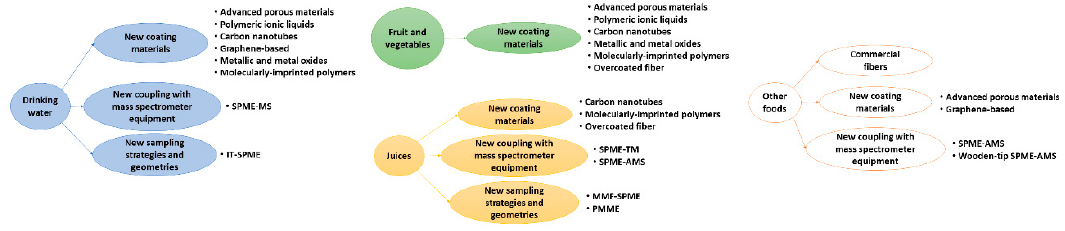
Figure 4. Main solid-phase microextraction geometries and strategies used in the analysis of food matrices during the covered period (2014–2019).